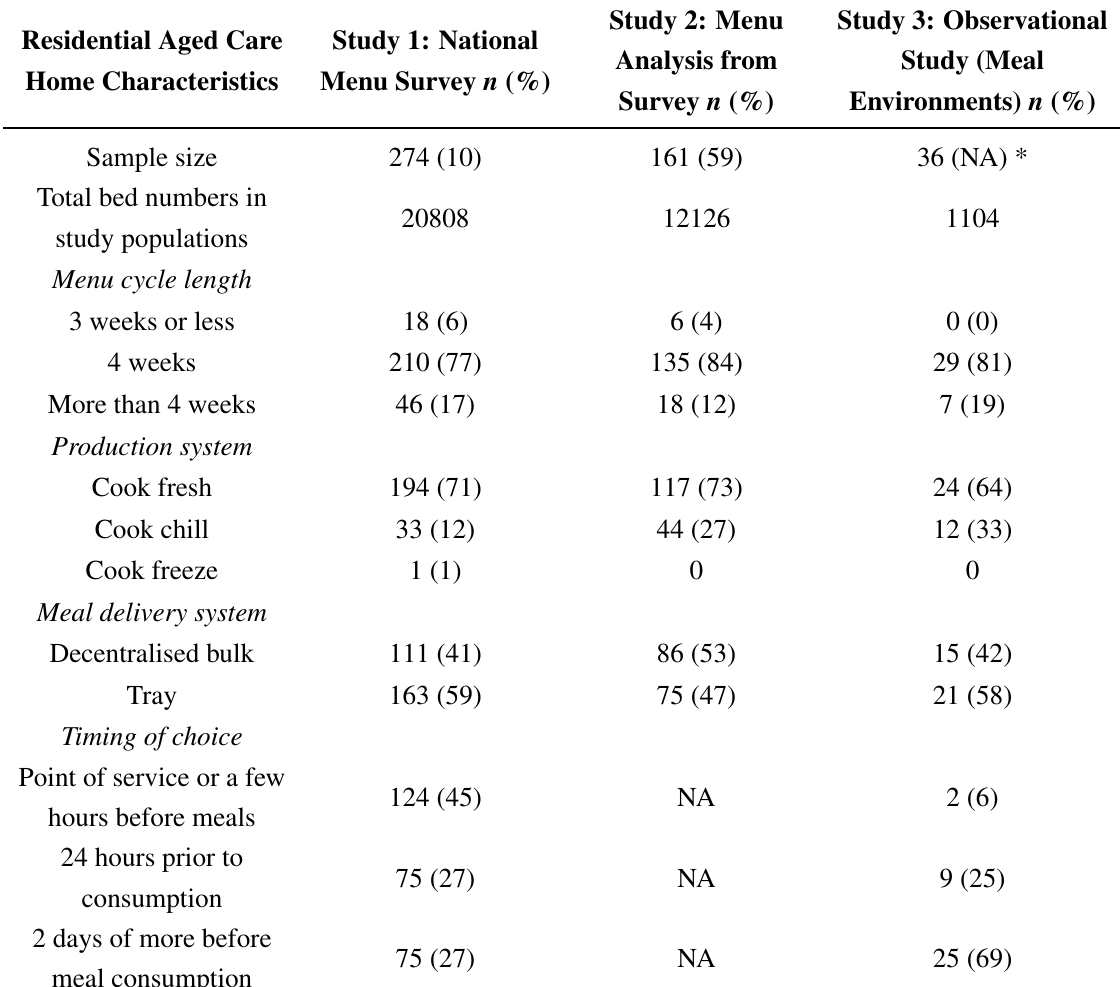
Table 1. Residential aged care home characteristics and foodservice systems across studies. Residential Aged